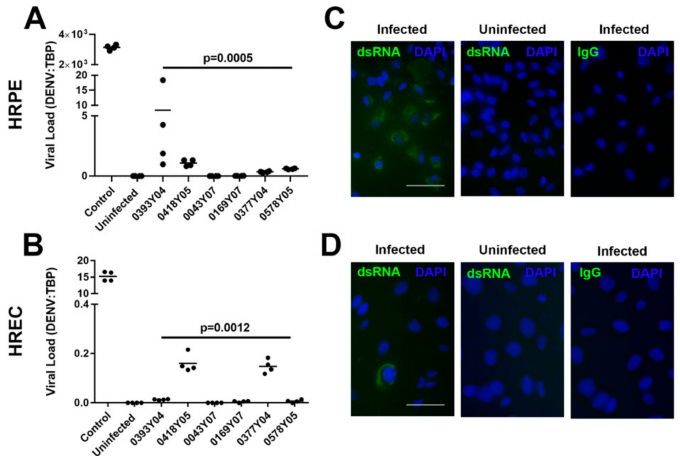
Figure 1. Susceptibility of human retinal pigment epithelial cells and vascular endothelial cells to infection with DENV-1 and DENV-2 strains: DENV-1 viral strains = Singapore National Environmen- tal Agency Isolate (EHI)0393Y04, EHI0418Y05 (from 2005 epidemic), EHI0043Y07 and EHI0169Y07 (from 2007 epidemic); DENV-2 viral strains = EHI0377Y04 and EHI0578Y05 (from 2005 epidemic); HRPE = ARPE-19 human retinal pigment epithelial cell line; HREC = human retinal vascular en- dothelial cell line, produced in-house; multiplicity of infection = 10; inoculation interval = 90 min; time of infection = 48 h. ( A , B ) Graphs showing viral load, expressed as DENV transcript relative to TATA box-binding protein (TBP). Dots represent individual cell monolayers ( n = 4 monolayers per condition) and crossbars represent means. Control was the laboratory-adapted Mon601 strain. Data were analyzed by Kruskal–Wallis test. ( C , D ) Representative photomicrographs of cell monolayers infected with Mon601 and immunolabelled for dsRNA or negative control immunoglobulin (IgG). Alexa Fluor 488 (green) with 40,6-diamidino-2-phenylindole (DAPI) nuclear counterstain (blue). Scale bar measures 50